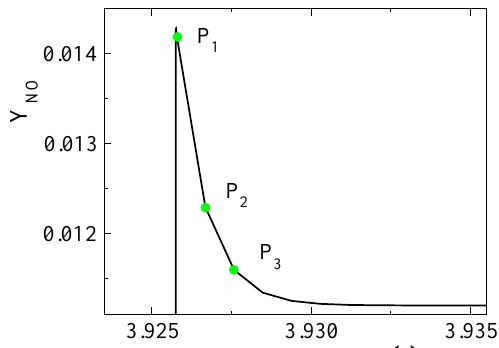
Figure 2. NO mass fraction and temperature evolution associated with pure NH 3 /air autoignition: ( a ) full explosive stage, ( b ) final part of the explosive stage.